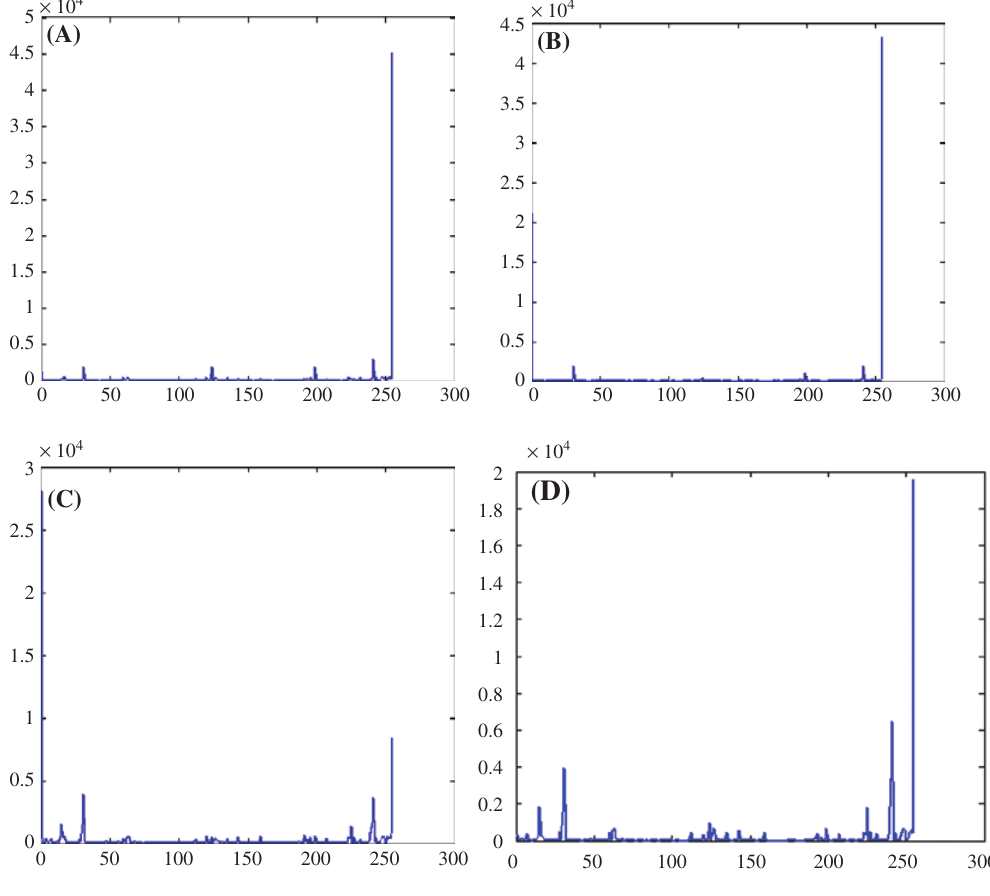
Figure 4: LVP of